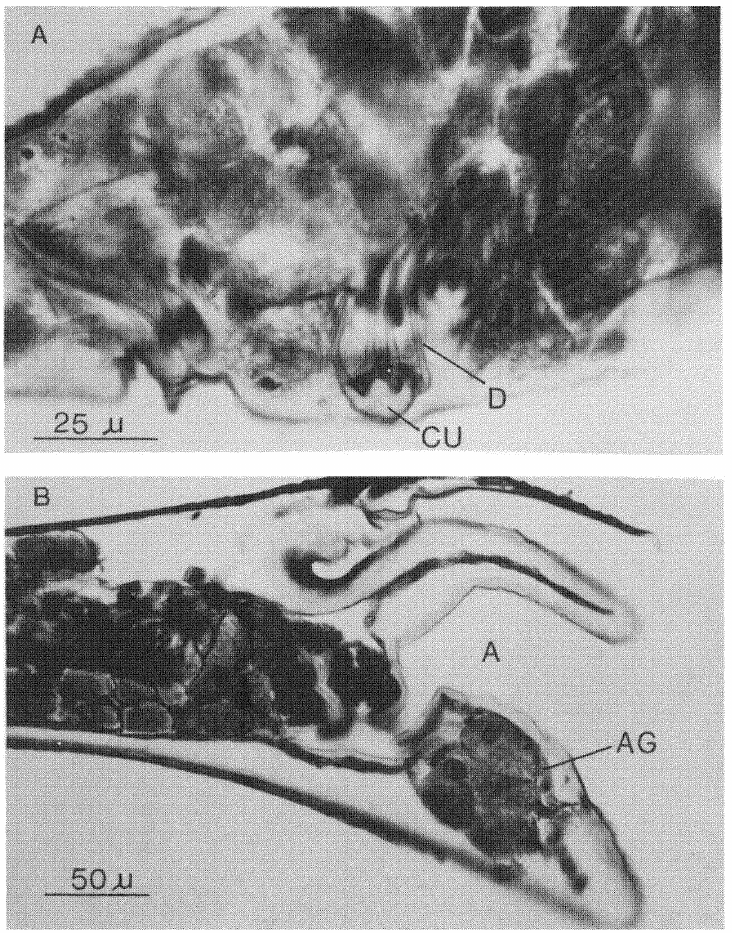
Fig. 7 A. Longitudinal section through sternal gland in 8th sternite of a Pachv- condvla apiacalis c. D=glandular duct; CU=cuticular cup. B. Longitudinal sec- tion through 8th tergite of a Ectatomma ruidum c. A=anus; AG=anus